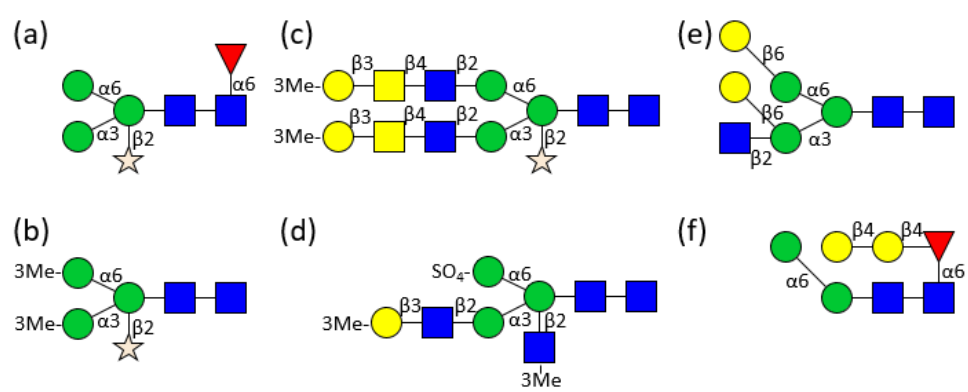
Figure 2. Examples for hemocyanin N-glycan structures from different molluscs. ( a ) Helix pomatia [21]; ( b ) Lymnaea stagnalis [22]; ( c ) Lymnaea stagnalis [23]; ( d ) Rapana venosa [27]; ( e ) Megathura crenulata [28]; ( f ) Megathura crenulata [29]. For the symbols key see Figure 1.